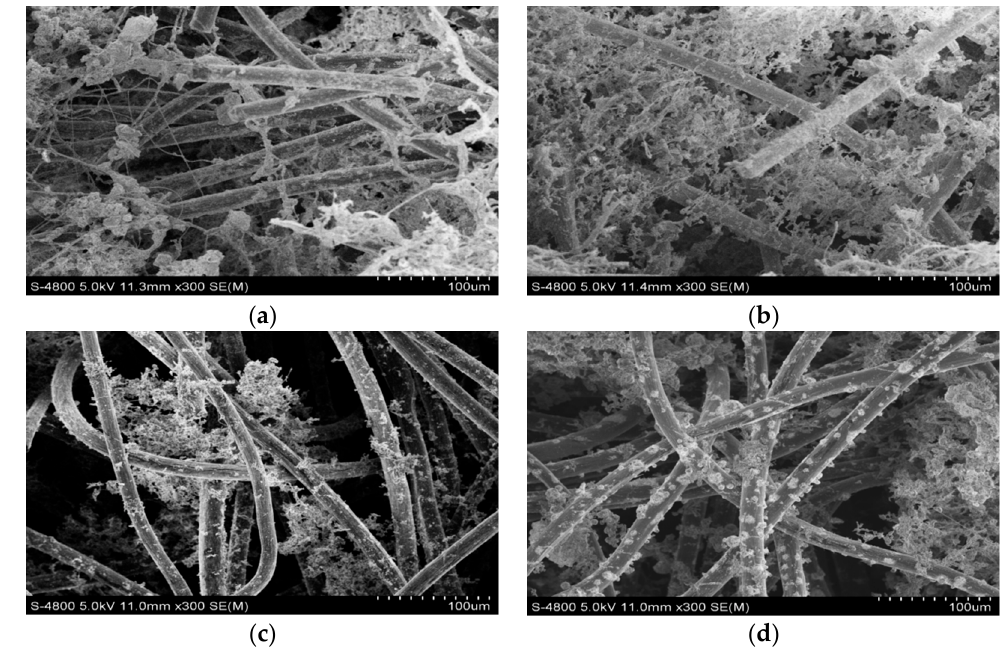
Figure 6. SEM images of the anode surface of three MFCs ( a ) A1; ( b ) A2; ( c ) A3 ( d ) A4.